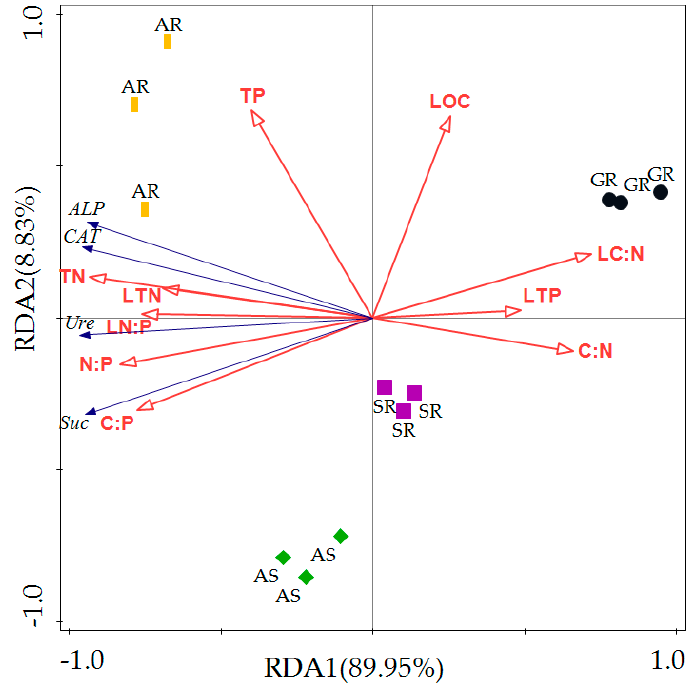
Figure 6. The redundancy analysis of soil enzyme activity and nutrient and ecological stoichiometry. Note: GR = grassland, SR = shrubland, AS = arbor and shrub compound forest, and AR = arbor forest. TN, soil total nitrogen content (g/kg); TP, soil total phosphorus content (g/kg); LOC, litter carbon content (g/kg); LTN, litter total nitrogen content (g/kg); LTP, litter total phosphorus content (g/kg); C:N, soil C:N ratio; C:P, soil C:P ratio; N:P, soil N:P ratio; LC:N, litter C:N ratio; LN:P, litter N:P ratio.